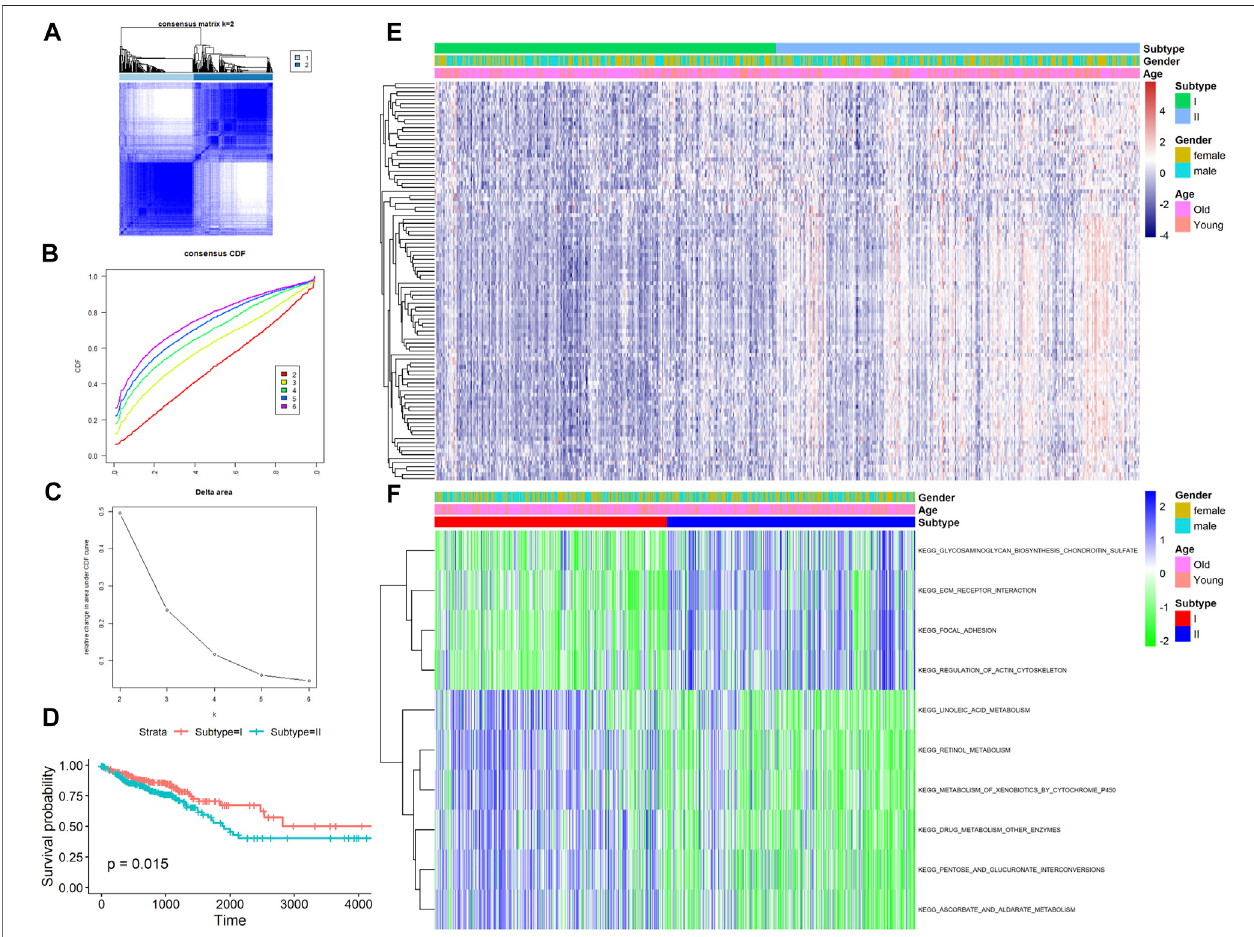
FIGURE3| Identi fi cation of twostemnesssubtypes with distinct survivaloutcomesand functionalenrichment. (A) Heatmap oftheconsensus clustering matrix for k=2; (B) CDFcurvesoftheconsensusscorefromk=2to9. (C) TherelativechangeintheareaundertheCDFcurvefromk=2to9. (D) Kaplan – Meieranalysisexhibited signi fi cantly better OS in stemness subtype I; (E) Heatmap of the expression patterns of top 100 DEGs between stemness subtype I and stemness subtype II. (F) Heatmap illustrated the enrichment scores of signi fi cantly enriched pathways evaluated by GSVA analysis between stemness subtype I and II.